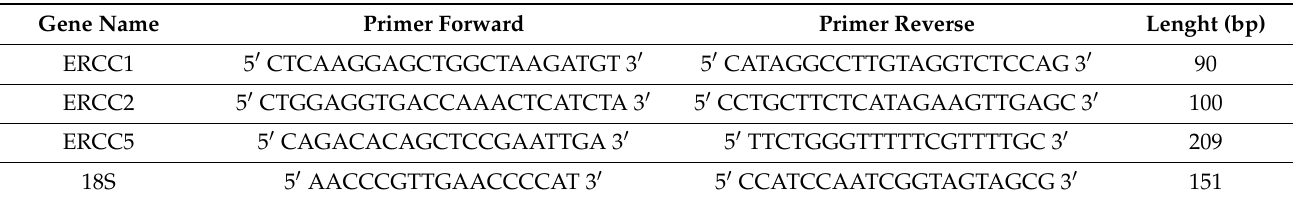
Table 2. Sequences of qPCR